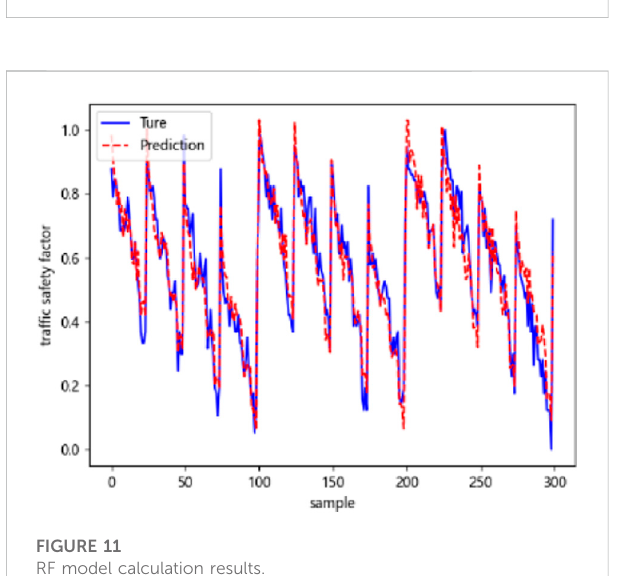
FIGURE 11 RF model calculation results.